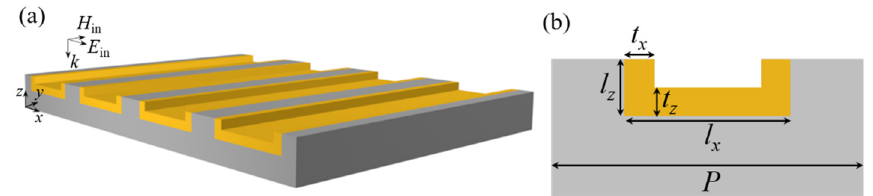
Figure 1. ( a ) Schematic view of the 3D Au U-shaped VSRRs array embedded in a silica substrate. ( b ) The magnified front views of a unit cell of the Au VSRRs array. The arm length and base length of the VSRR, the Au thickness along the x and z axis, and the period of the VSRR array are denoted as l z , l x , t x , t z , and P , respectively.